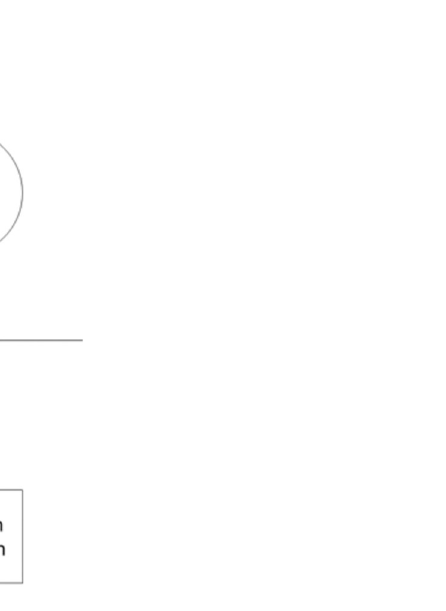
Fig 1. (a) top panel: Item factor loadings, Study 1; (b) bottom panel: Structural model, Study